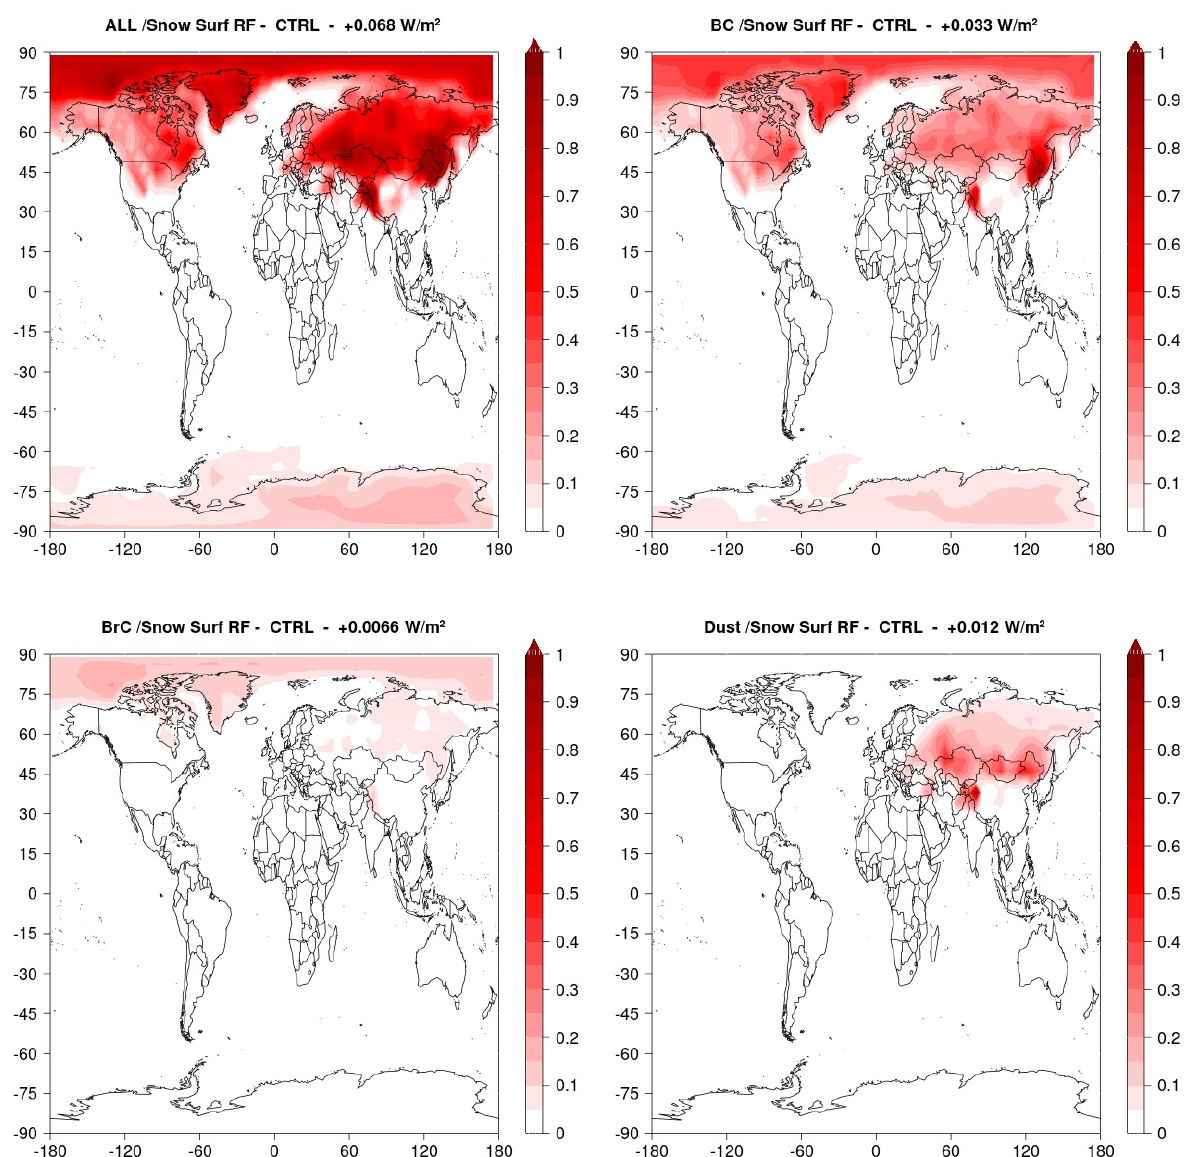
Figure 4. All-sky annual mean (2010–2014) radiation-absorbing aerosols (RAAs), black carbon (BC), brown carbon (BrC), and soil dust in snow radiative forcing (RF) calculated from the CTRL experiment.